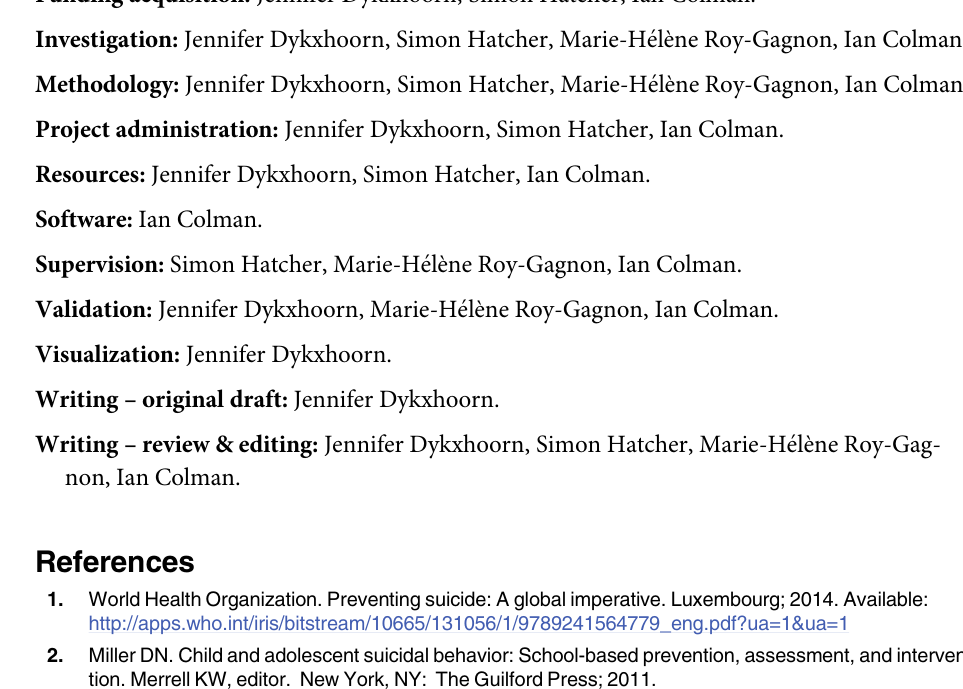
S10 Table. Odds ratio estimates and 95% confidence limits for stepwise selection logistic regression model, NLSCY. S1 Fig. Conceptual model–social ecological model of suicidality. S2 Fig. Classification and regression tree (CART) model, NLSCY, N (unweighted) and rate of suicidal thoughts